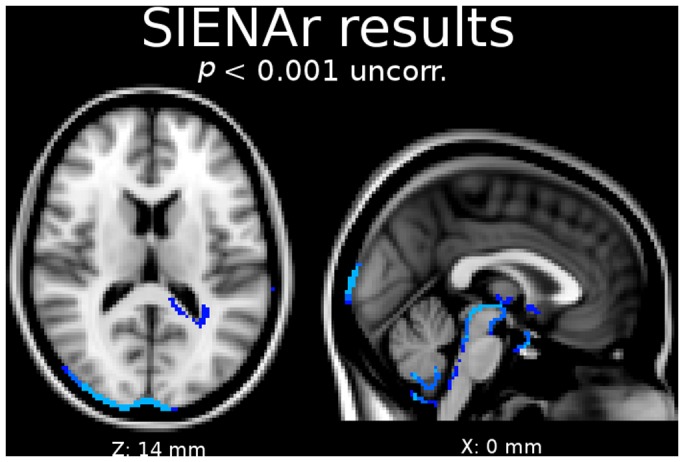
Blue color shows effects due to dehydration in regions of the third, fourth, and right lateral ventricle computed with SIENAr (voxel level, uncorrected).Additionally, effects in the region of the occipital cortex were detected.